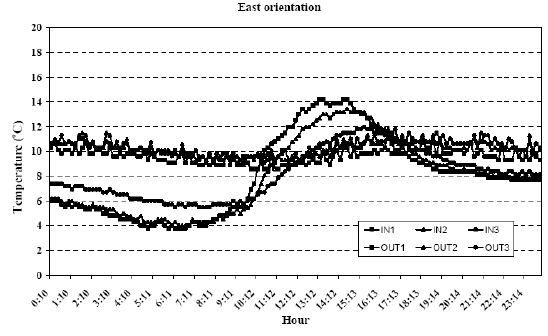
Figure 6. Temperature distribution inside and outside at south wall Winter period .